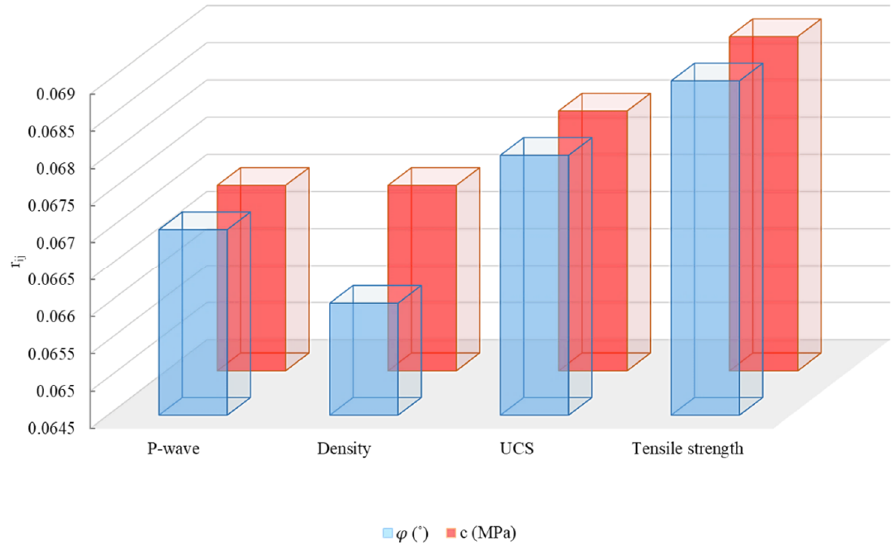
Figure 9. Sensitivity analysis values of (cid:2030) (°) and c (MPa).